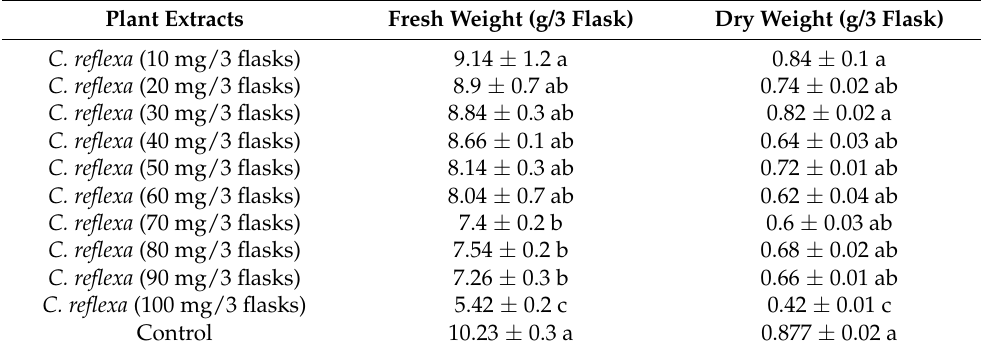
Table 2. Effect of different Cuscuta reflexa extracts on the fresh and dry weights of adventitious root cultures of Stevia rebaudiana after the completion of the experiments. Mean values with standard deviation ( ± SD) of the means did not exceed 5%. Mean values for each treatment were obtained from three independent experiments. Mean values with common alphabets are significantly different at p <